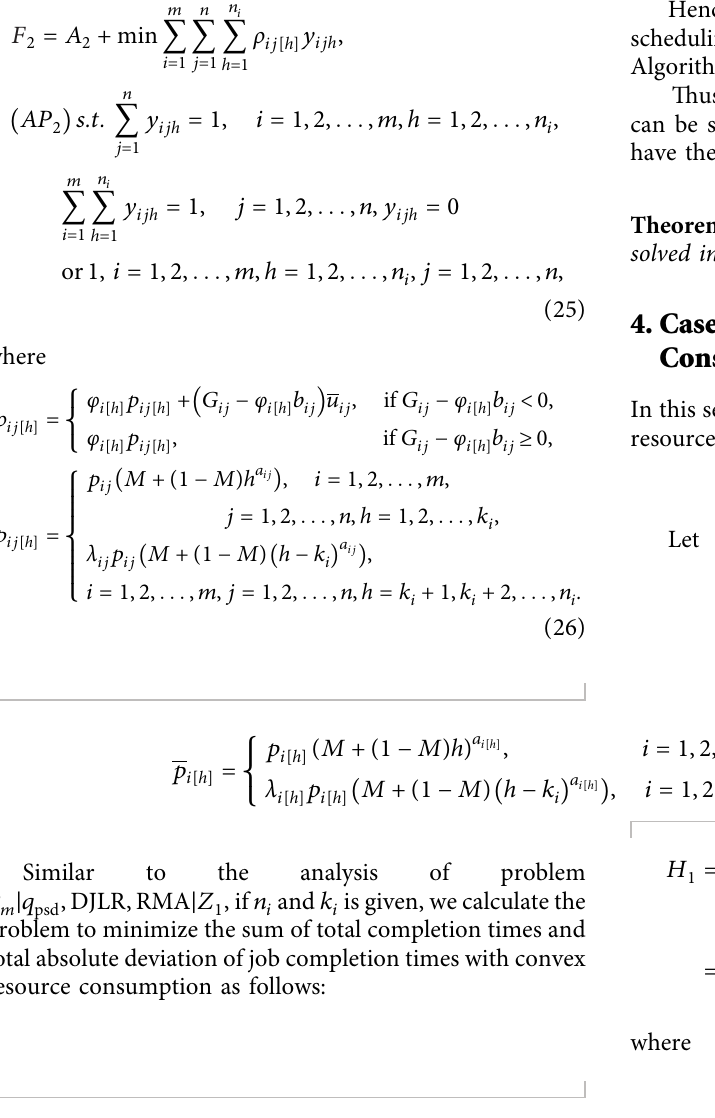
with linear resource